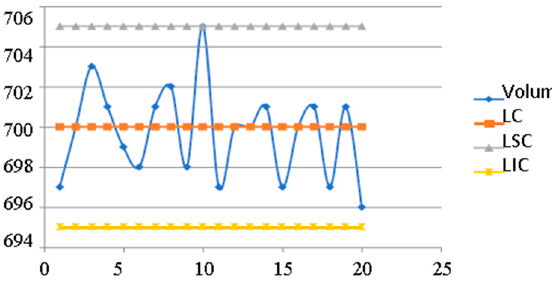
Figure 7. Control chart for the filling degree of Metaxa bottles. V = 700 mL. n = 20